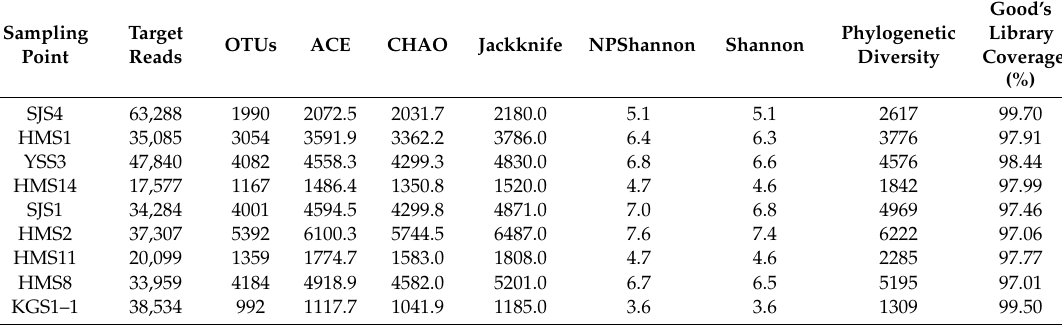
Figure 11. Taxonomic classification of bacteria samples at phylum and class level, and UniFrac UPGMA clustering (used software: PAST3, algorithm: Paired group (UPGMA), similarity index: Euclidean) of the bacteria communities. Table 2. Microbial diversity